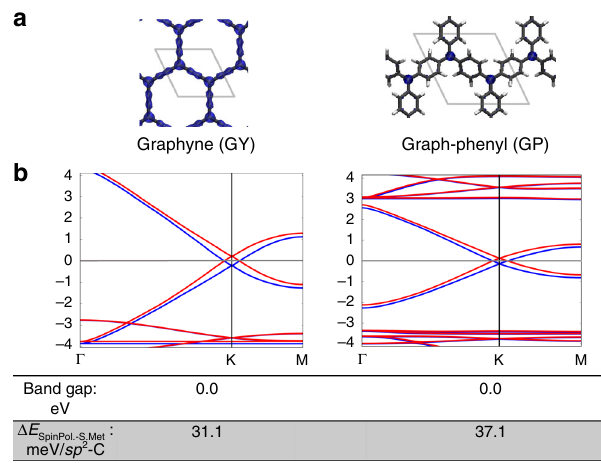
Fig. 5 Spin-polarised state. Results from spin-unrestricted open-shell static single point PBE0 calculations forcing a net spin polarisation of 0.15 unpaired electrons using the corresponding previously optimised structures in the semimetallic state. a Spin density iso-surface on GY (left) and GP (right) structures (alpha = blue; beta = red), where the unit cell is highlighted. b Corresponding electronic band structures for GY (left) and GP (right). Below the plots band gap values (eV) and the energy difference between the spin-polarised state and the corresponding purely semimetallic state ( Δ E SpinPol.-S.Met ) in meV is given for each